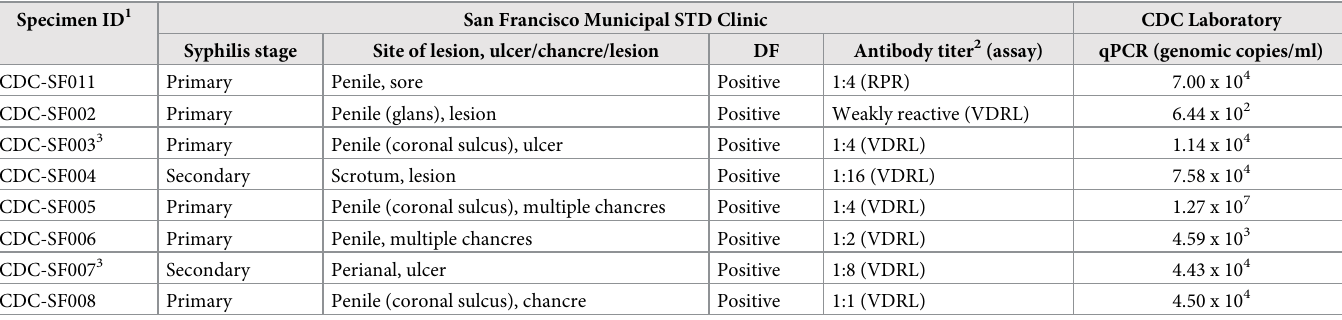
Table 1. Clinical and laboratory data for patient specimens used for in vivo rabbit